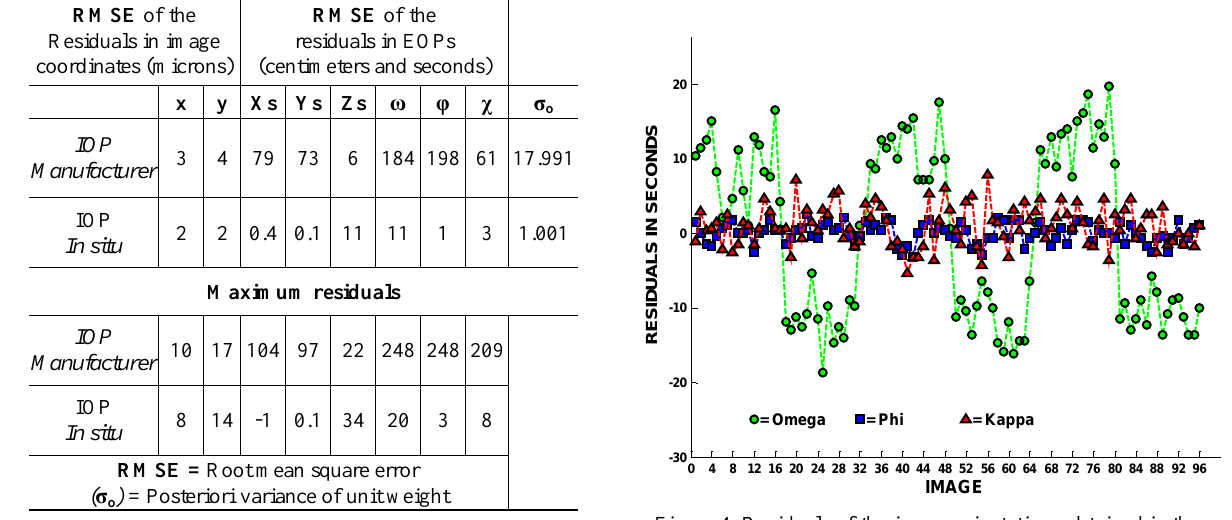
Figure 3. Residuals of the image positions obtained in the ISO experiment using IOP in situ camera calibration